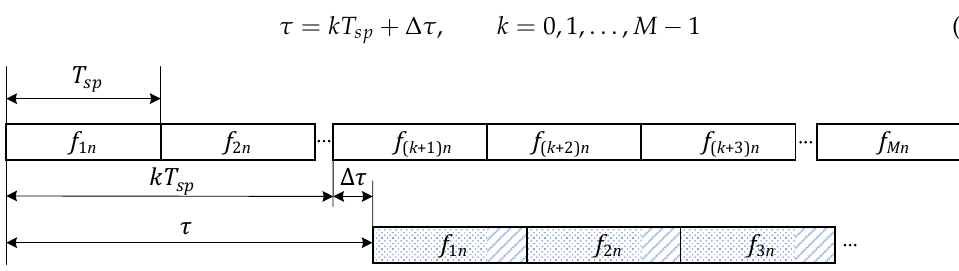
Figure 3. Frequency code relationship and sub-pulse division with delay τ